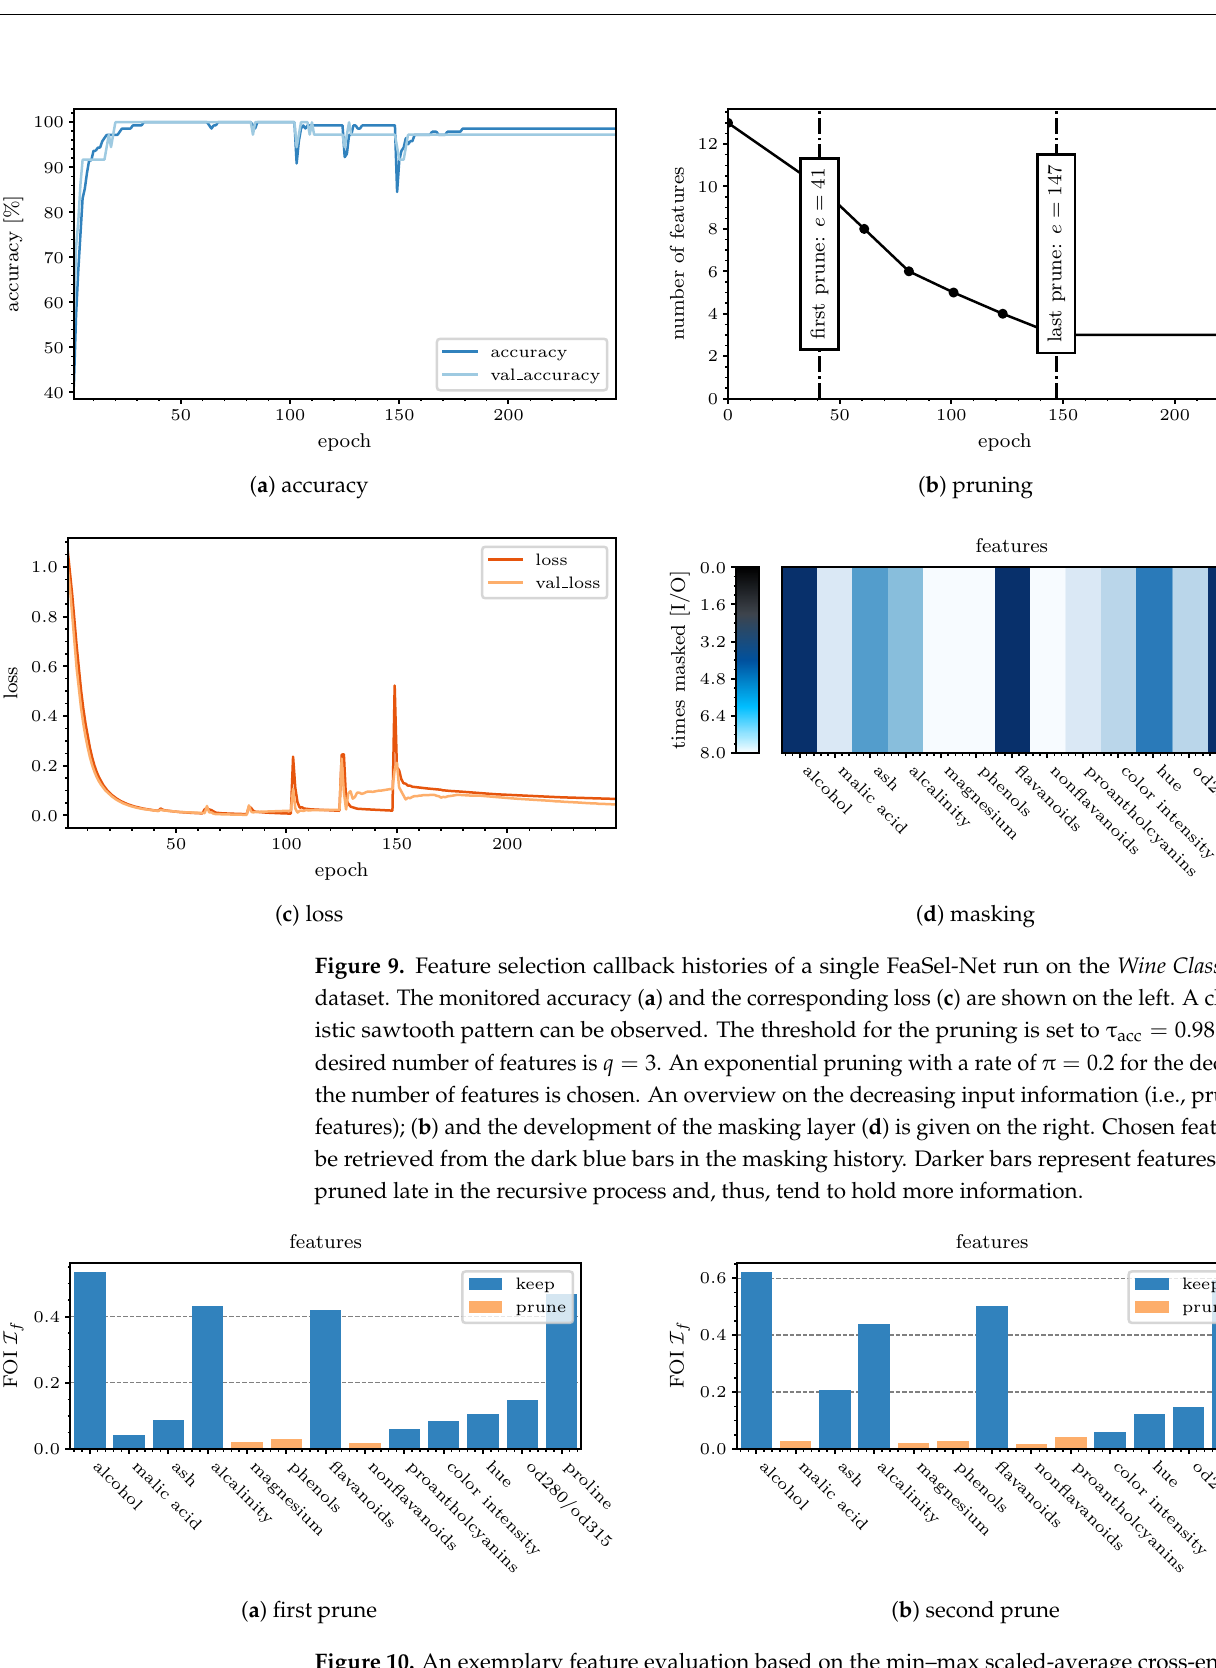
Figure 10. An exemplary feature evaluation based on the min–max scaled-average cross-entropy at different stages in the callback. The bars in ( a ) show the feature omission impact (FOI) in the first pruning stage, whereas the second prune is depicted in ( b ). Orange bars represent features that are or have already been pruned at each specific